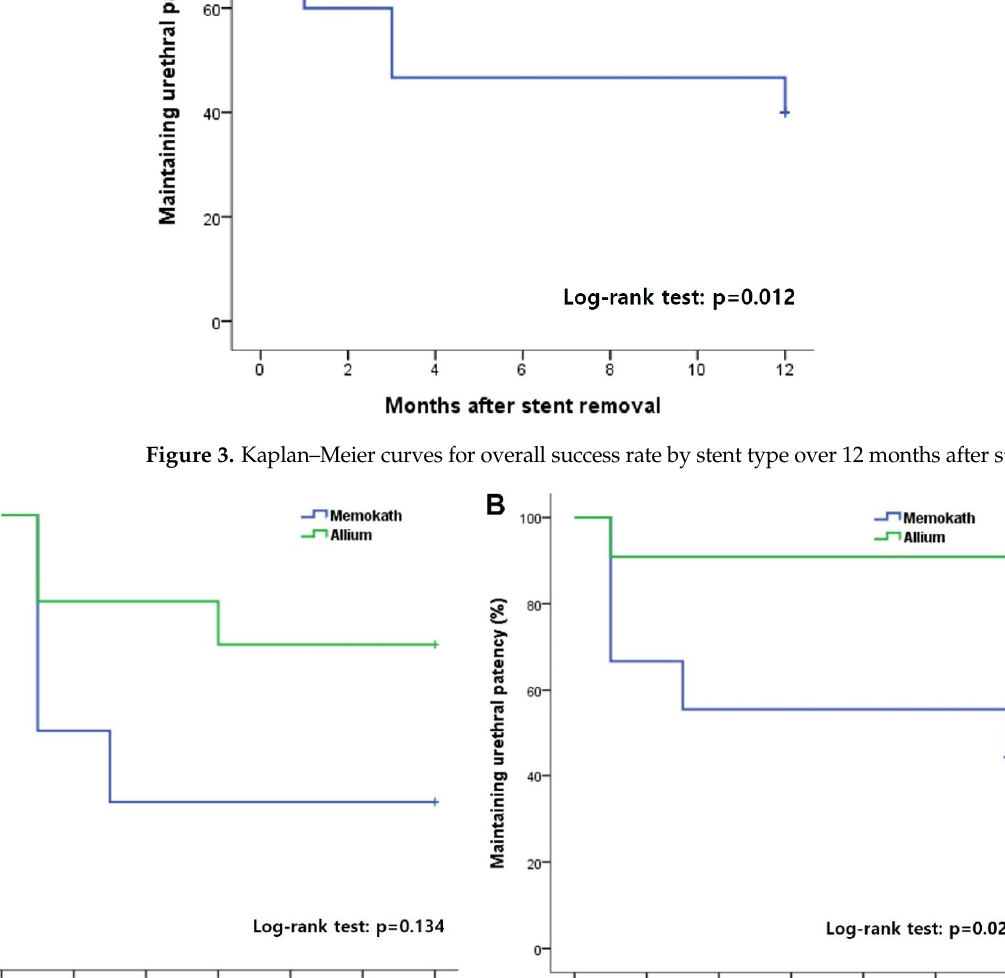
Figure 4. Kaplan–Meier curves showing the maintaining urethral patency rate with Memokath and Allium stents in groups subdivided into patients with direct visual internal urethrotomy with ( B ) or without ( A ) transurethral endoscopic removal of urethral scar tissue.